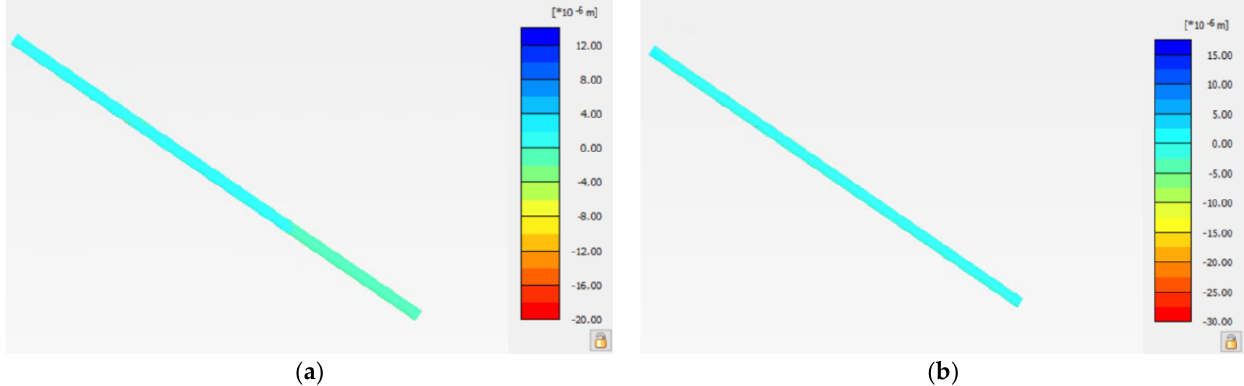
Figure 18. Displacement of east injection inclined shaft . ( a ) Horizontal displacement of east injection inclined shaft; ( b ) vertical displacement of east injection inclined shaft.